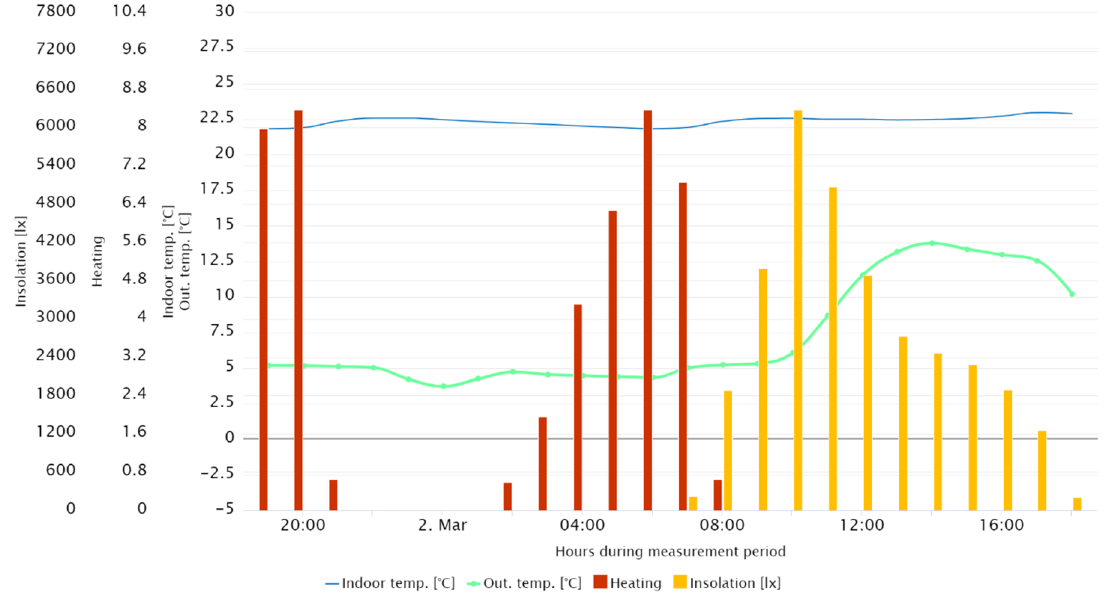
Figure 12. Twenty-four-hour period hourly averages of internal temperature for room 140 referring to heating valve position, insolation, and outdoor temperature.